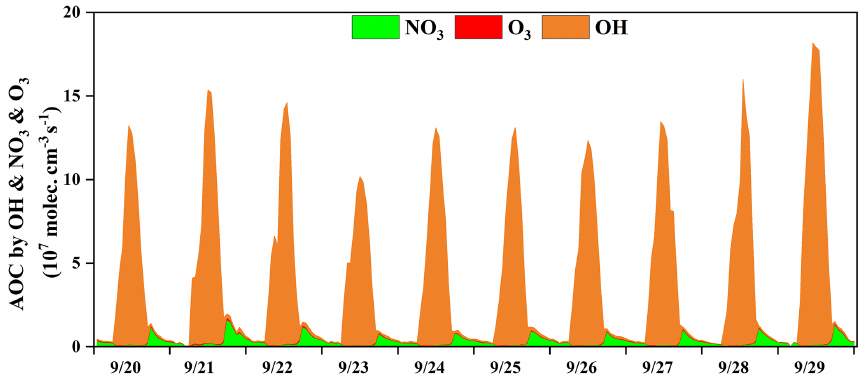
Figure 3. Time series of the model-calculated atmospheric oxidation capacity (AOC) in Xiamen during 20–29 September